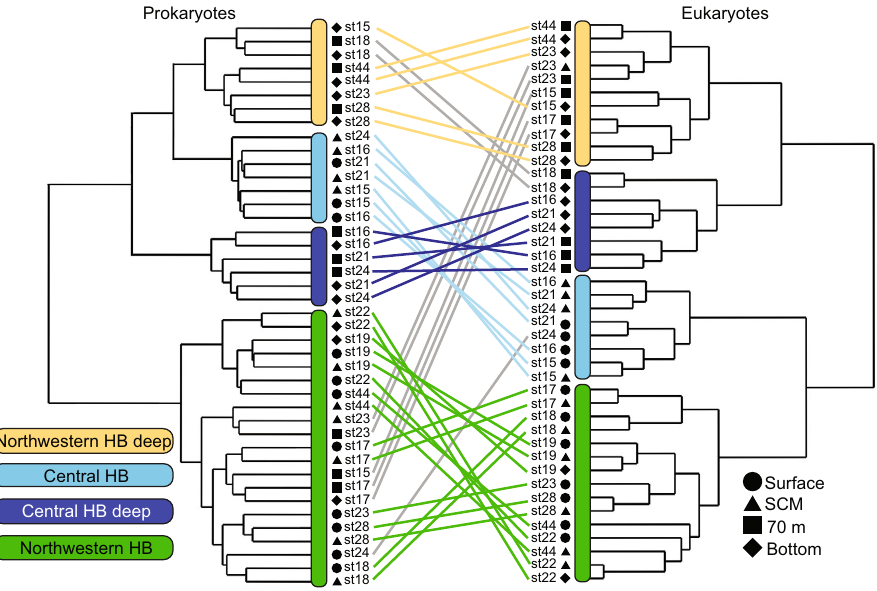
Fig. 2 Microbial community structure. The dendrograms were constructed with Bray – Curtis distance of the 44 samples using the “ ward.D2 ” method: prokaryotes (left tree) and eukaryotes (right tree). Symbols at the leaf extremities indicate depth category. Lines between the dendrograms show corresponding eukaryote and prokaryote placements from the same samples. The line color corresponds to designated environmental clusters when clustering is congruent. Grey lines indicate divergence of categories between eukaryotes and prokaryotes.